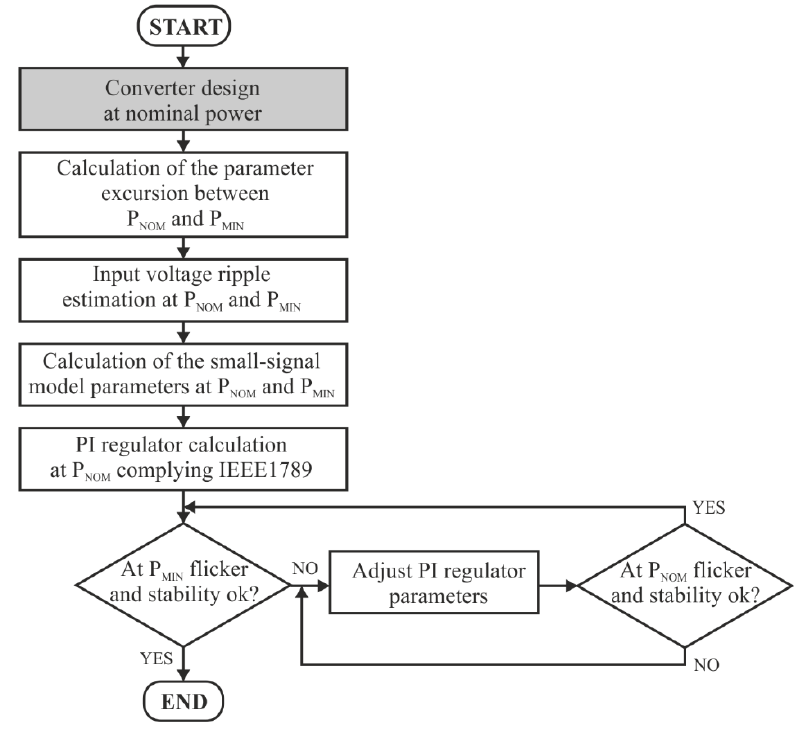
Figure 14. Proposed design methodology.